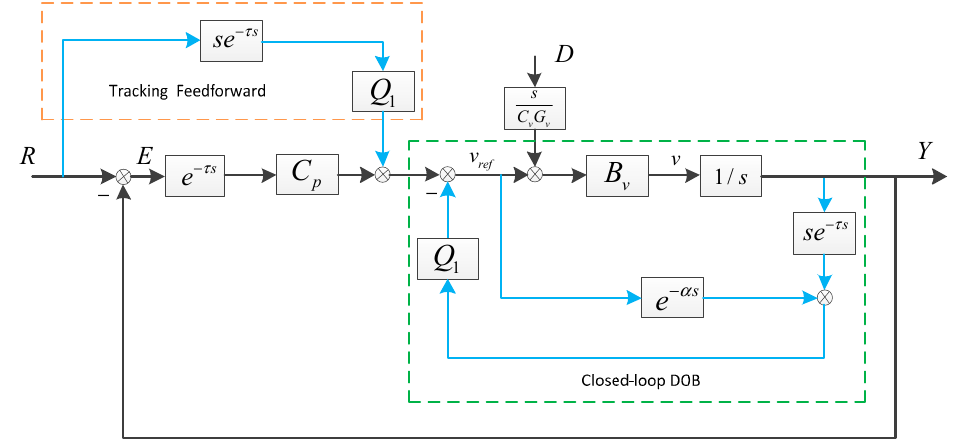
( ) / 1 B C G C G = + refers to the closed-loop transfer Figure 5. The equivalent structure of EOB. Figure 5. The equivalent structure of EOB. B v = C v G v / ( 1 + C v G v ) refers to the closed-loop transfer v v v v v B ≈ at a low frequency. function. B v ≈ 1 at a low function. 1 v